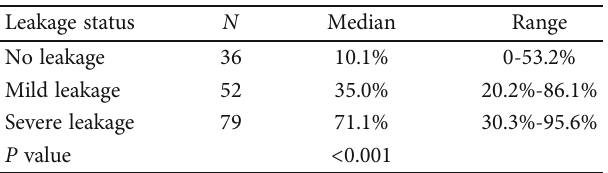
Figure 6: Percentages of presence of nearby cystoid spaces around diabetic microaneurysms in di ff erent fl uorescein leakage groups. Table 2: Flow proportion of diabetic microaneurysms by OCT B-scan with fl ow